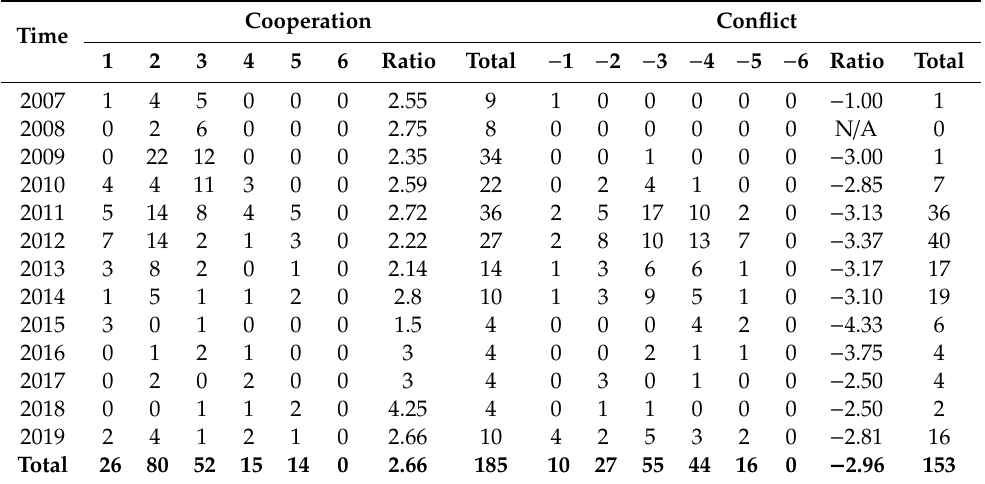
Table 1. TWINS analysis—cooperation and conflict intensity over the Xayaburi dam. Cooperation